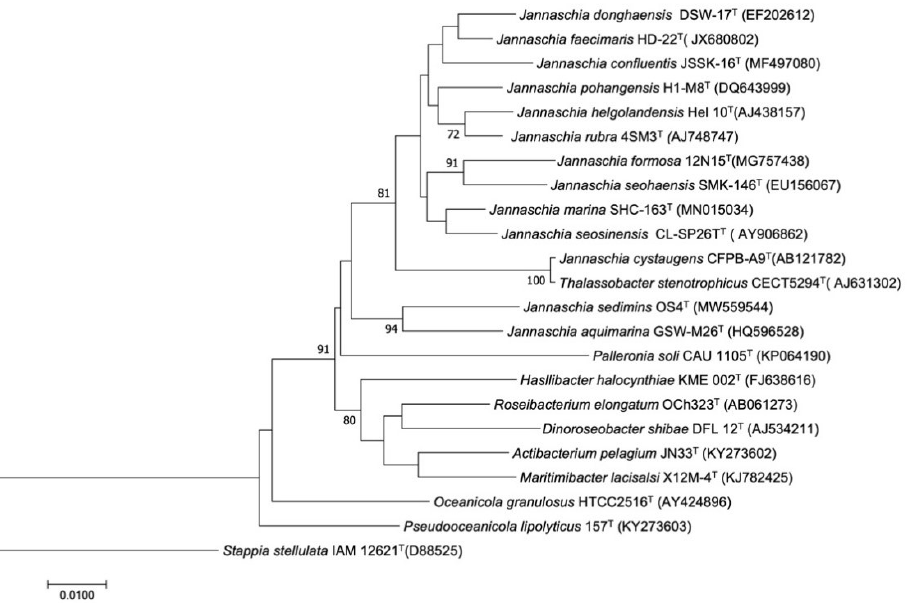
Figure 3. Phylogenetic relationship of strain OS4 T and other related species. Neighbor-joining phylogenetic tree based on 16S rRNA gene sequences, showing the relationships of strain OS4 T and related species. Bootstrap values ≥ 70% (based on 1000 replications) are shown at branching nodes. Stappia stellulata IAM12621 T (GenBank accession number, D88525) was used as an outgroup. Bar, 0.01 substitutions per nucleotide position.